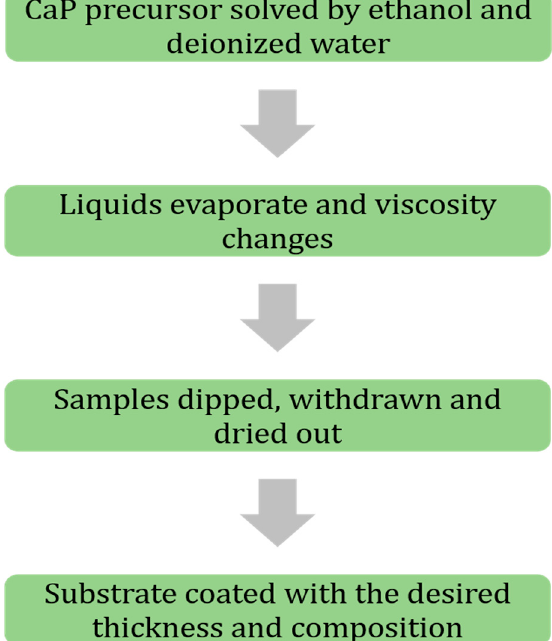
Figure 1. Flowchart of sol-gel coating process coating steps, in brief.